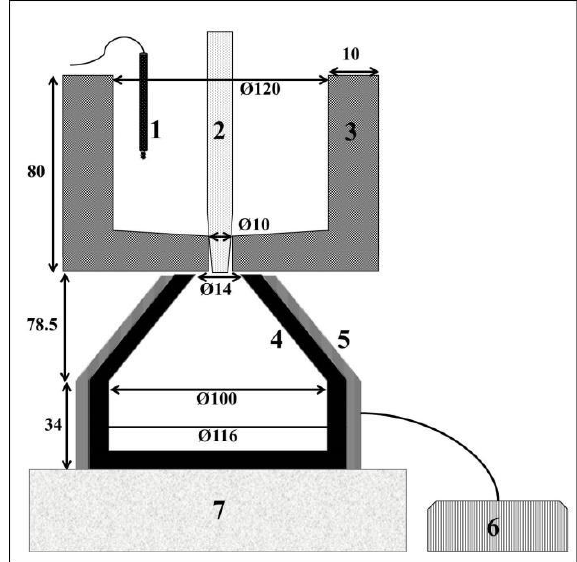
Figure 2. Schematic diagram showing ( a ) top and ( b ) side views of the mold used to measure thermal stress and shrinkage starting temperature (SST): (1) injection hole, (2) thermocouple 1, (3) thermocouple 2, (4) the point at which the temperature of melt in the mold was estimated, (5) inner heaters, (6) pin, (7) heating plate, (8) load cell, (9) fixed column, (10) thermocouple 3. ( c ) Image of the top view of the actual mold. Typical profiles of ( d ) thermal stress and ( e ) shrinkage displacement measured in the mold. Thermocouple 1 and 2 were fixed at 20 mm above the bottom of the mold.